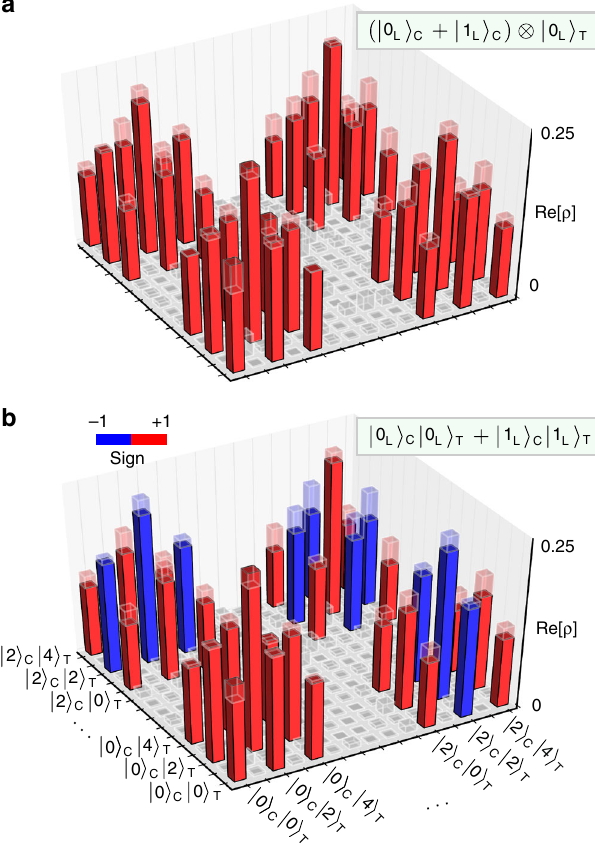
Fig. 3 Generation of a multiphoton Bell state. Reconstructed density matrices (solid bars) of a , the initial separable two-cavity